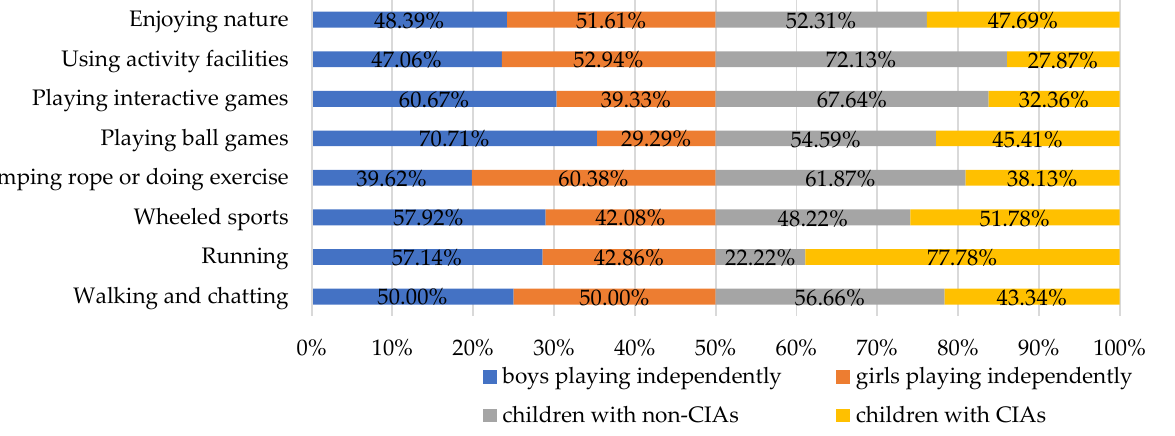
Figure 3. Gender difference of CIAs and proportion of CIAs and non-CIAs.